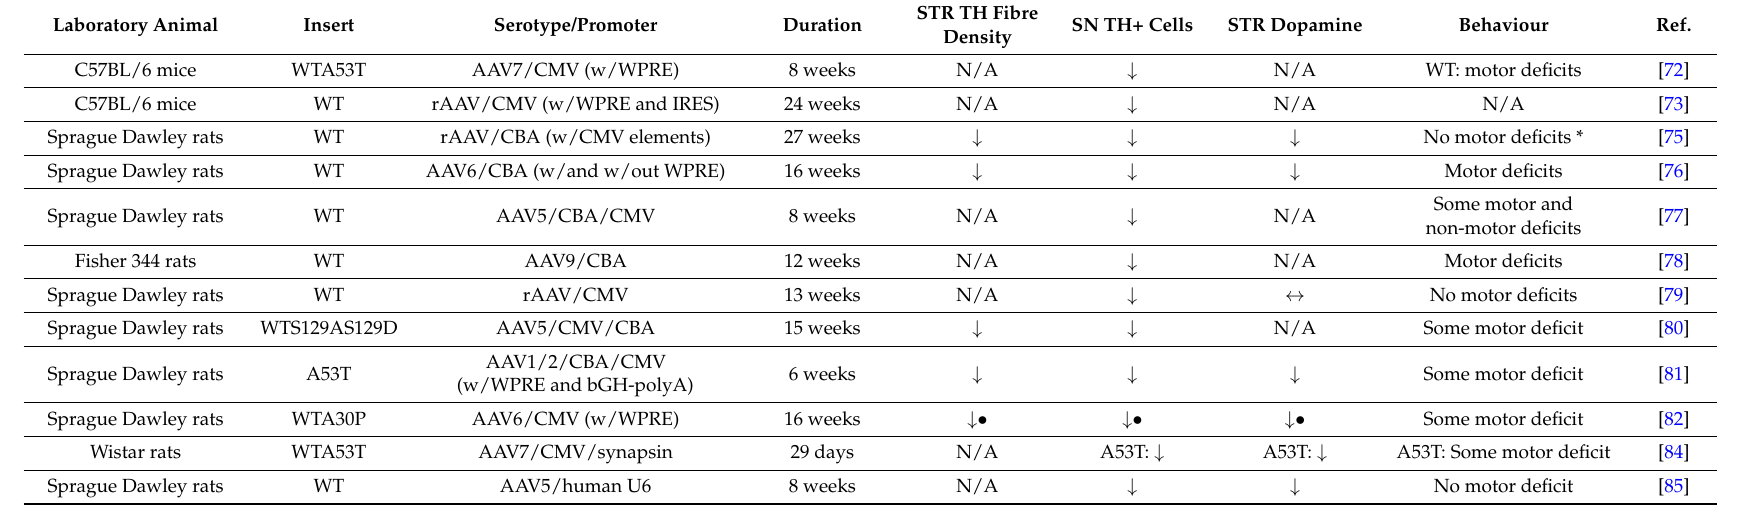
Table 1. Summary of articles with human adeno-associated virus (AAV)- α -synuclein unilaterally injected to the substantia nigra of animals where outcomes are compared to AAV-green fluorescent protein (GFP). Animal and strain are listed, along with serotype, promoter, and if any enhancers are used. The total duration of each experiment is listed, though earlier time points may have also been measured. Striatum tyrosine hydroxylase (TH) fibre density is defined as the TH optical density as a percentage of the control side, TH+ cell loss refers to either total cells or a percent of the control side, striatum dopamine content is measured by HPLC, and behaviour refers generally to any behavioural assays that were performed in the